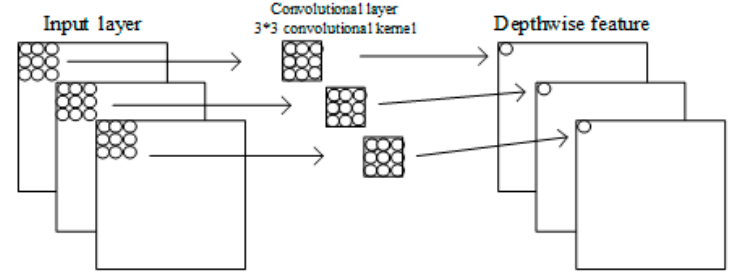
Figure 4. Variation of standard convolution compared to MobileNet convolution.